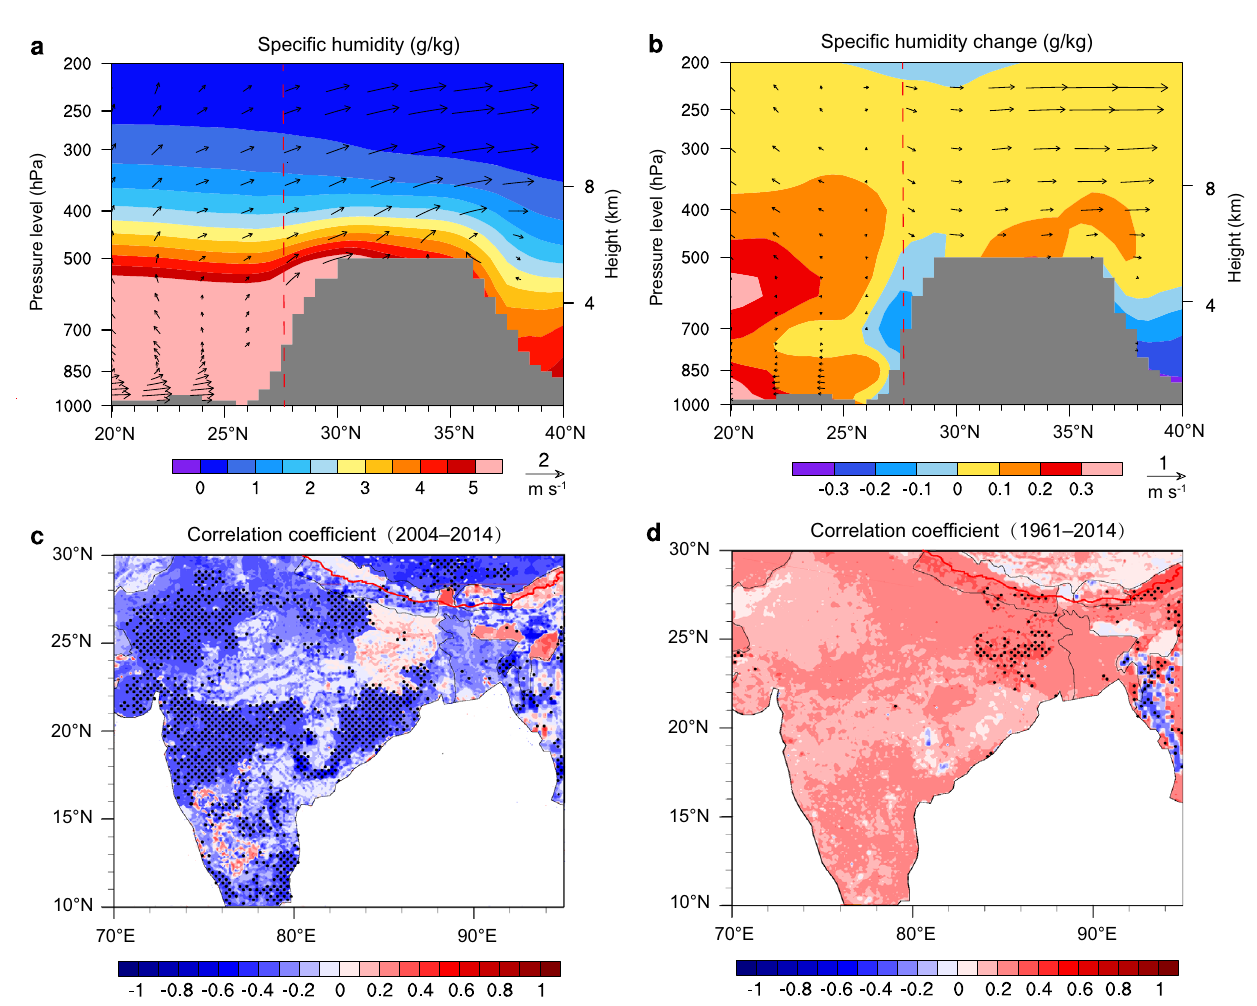
Fig. 2 | Meridional moisture transport (using the ERA-Interim dataset) from South Asia to the Tibetan plateau, together with the linkage of South Asian black carbon to summer precipitation over the southern Tibetan plateau. a Cross-section of meridional averaged (80° – 90° E) moisture transport for the period 1989 – 2018. b Cross-section of meridional averaged moisture transport change between the periods 1989 – 2003 and 2004 – 2018. c , d Correlation coef fi - cients between area-averaged precipitation over the southern Tibetan plateau using a subset of the CRU dataset (1961 – 2014) to concur with Peking University ’ s